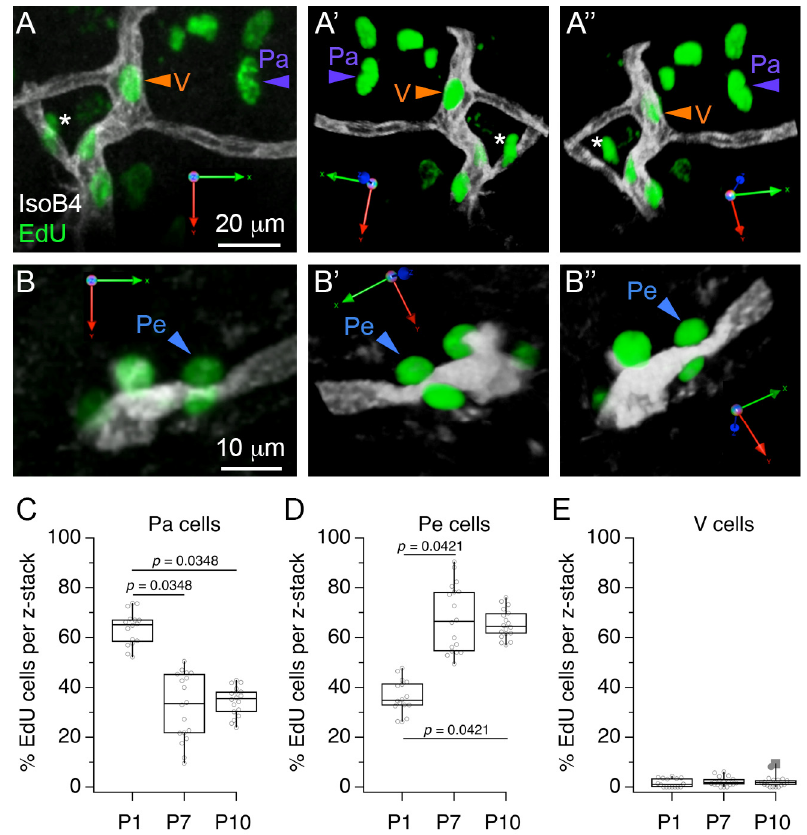
Figure 4. Classification of proliferative cells in the medial nucleus of the trapezoid body (MNTB) vascular niche. ( A ) Exemplar 3D rendering of IsoB4 and EdU double-labeled profiles illustrate the location of parenchymal (Pa) and vascular (V) EdU-labeled cells with respect to IsoB4-labeled vessels. Panels ( A’ , A” ) indicate different rotation viewpoints. The asterisk indicates a parenchymal cell close to a vessel branch point. ( B ) Exemplar 3D rendering illustrates perivascular (Pe) EdU-labeled cells with respect to IsoB4-labeled vessels. ( B’ , B” ) indicate different rotation viewpoints. ( C ) Percent Edu-labeled cells in the Pa category. ( D ) Percent EdU-labeled cells in the Pe category. ( E ) Percent EdU cells in the V category. Scale bars in ( A , B ) apply to ( A’,A” , B’ , B” ), respectively.